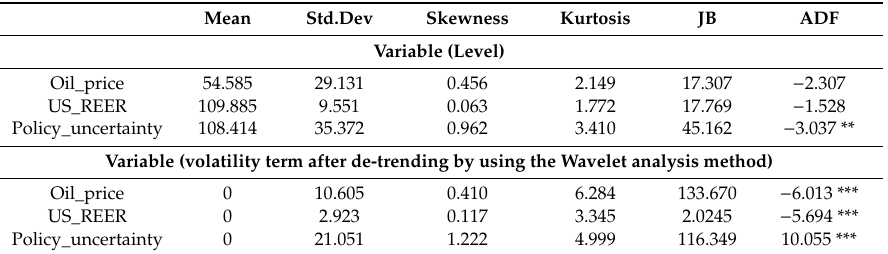
Table 1. Results of descriptive statistics and unit root